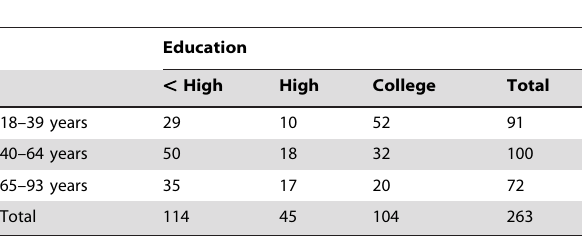
Table 1. Number of participants by age and